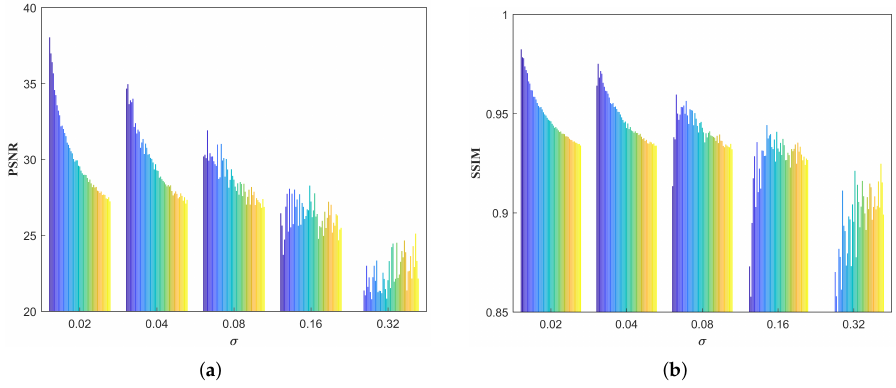
Figure 14. PSNR (dB) and SSIM results for Lena with different i max values in the five stripe noise cases. ( a ) PSNR; ( b ) SSIM.